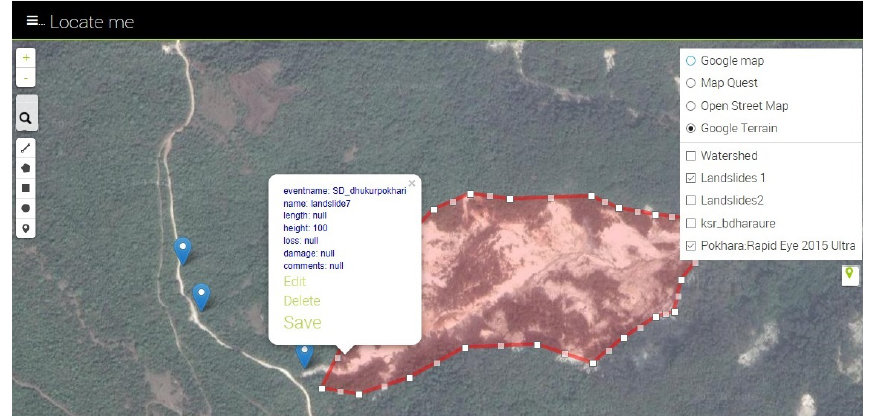
Figure 8. Online component: a landslide event with the options of editing the feature directly into the online database and adding different layers as base layers such as Google Maps, a shapefile, or satellite images (Pokhara: RapidEye 2015).